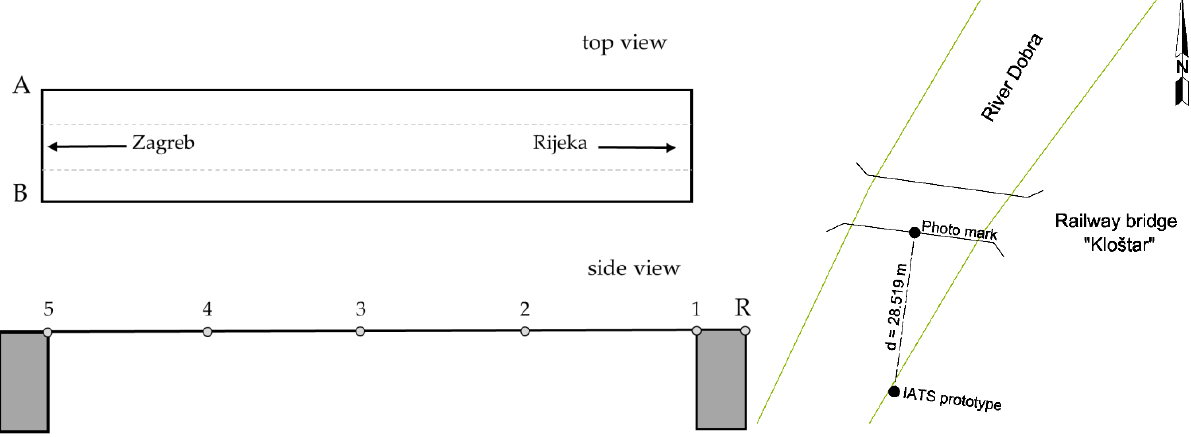
Figure 7. Schematic representation of the bridge (left). Top view shows the measuring lines (A, B) for geometric leveling of the bridge, while side view shows measuring spots (1–5) on measuring lines for the purpose of static load testing. The sketch on the right side represents IATS prototype setup in the field in relation to the bridge for the purpose of dynamic load testing.